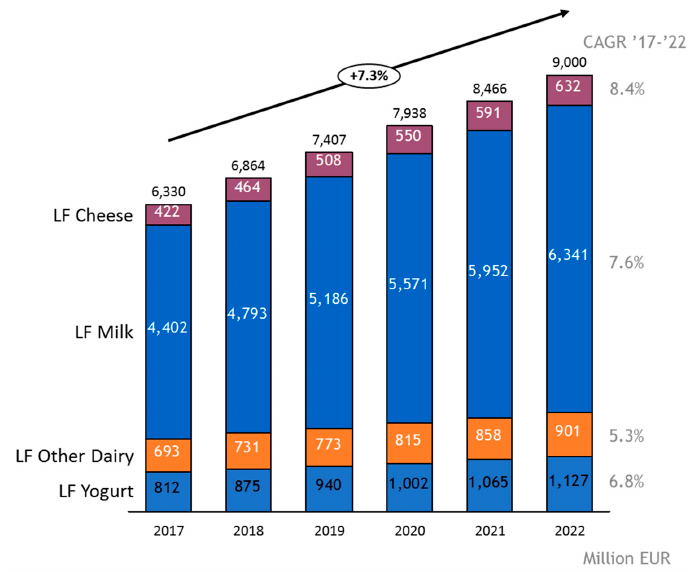
Figure 1. A compounded annual growth rate (CAGR) estimate of the lactose-free dairy market segment over the period 2017–2022. The total yearly turnover in M€ is indicated. LF: lactose-free. The figure was created from data of the Euromonitor analysis [6].